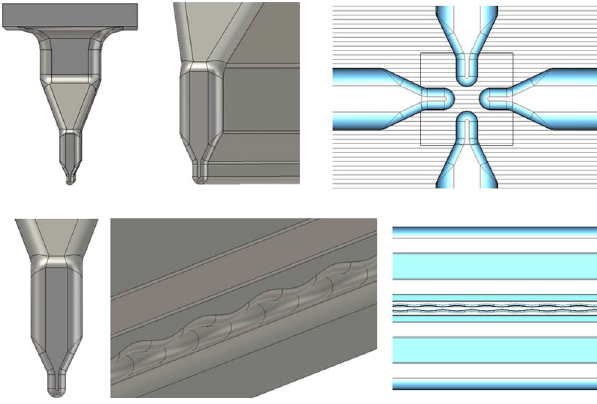
FIG. 2. 3D modeling of the RFQ in MWS.